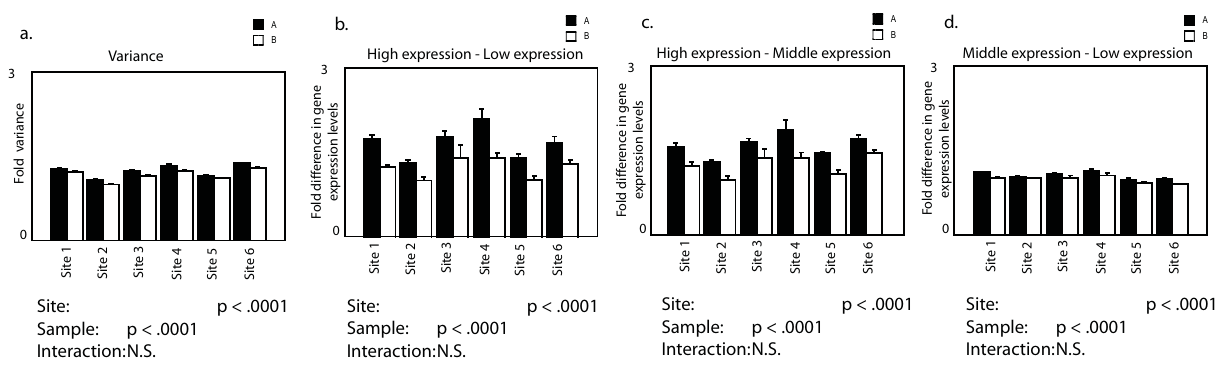
Figure 7. Global differences in gene expression patterns are robustly detected at multiple testing sites. To validate our approach to microarray analysis, we analyzed an independent publicly available dataset from the MicroArray Quality Control Project. Here two commercially available samples (Sample A=Stratagene Universal Human Reference RNA (UHRR, Catalog # 740000), Sample B=Ambion Human Brain Reference RNA (HBRR, Catalog # 6050)) were sent to six independent testing sites that ran 5 technical replicates for each sample. At all testing sites sample A had a greater variance of log-transformed gene expression levels than sample B. In all cases this was accompanied by a moving apart of gene expression distributions. A strongly significant effect of testing site on all measurements was also present. The effects of sample and site did not interact.